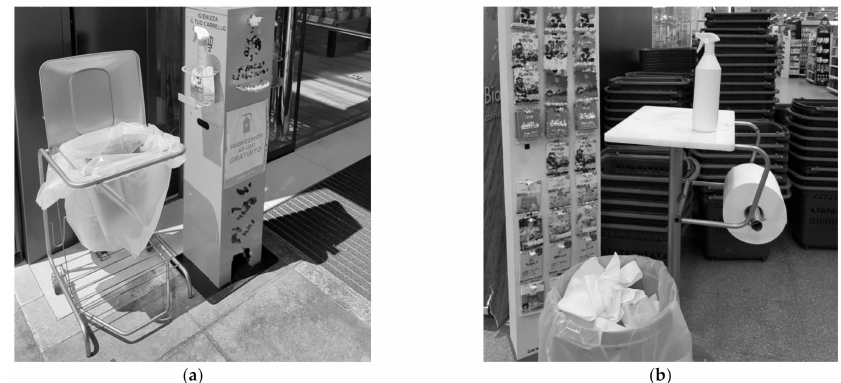
Figure A2. Images illustrating two examples of sanitizer dispensers for collectively used containers, such as shopping carts or baskets ( a , b ), usually equipped with kitchen paper rolls and a bin.